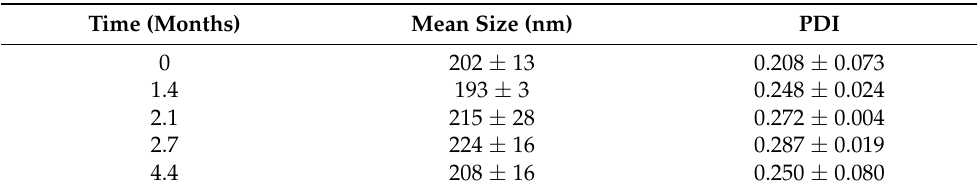
Table 5. Mean size and PDI of the formulation over time.